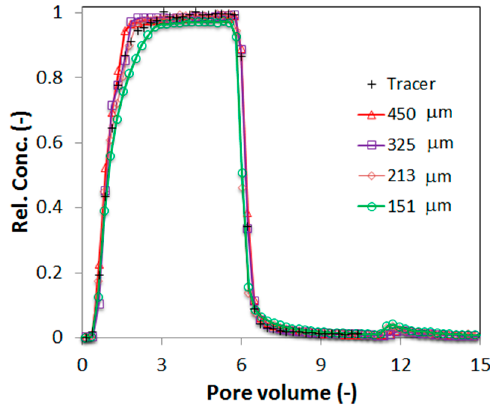
Figure 7. Representative FBP breakthrough curves from column experiments using fire extinguishing water collected at site 2 with four different porous media grain sizes.